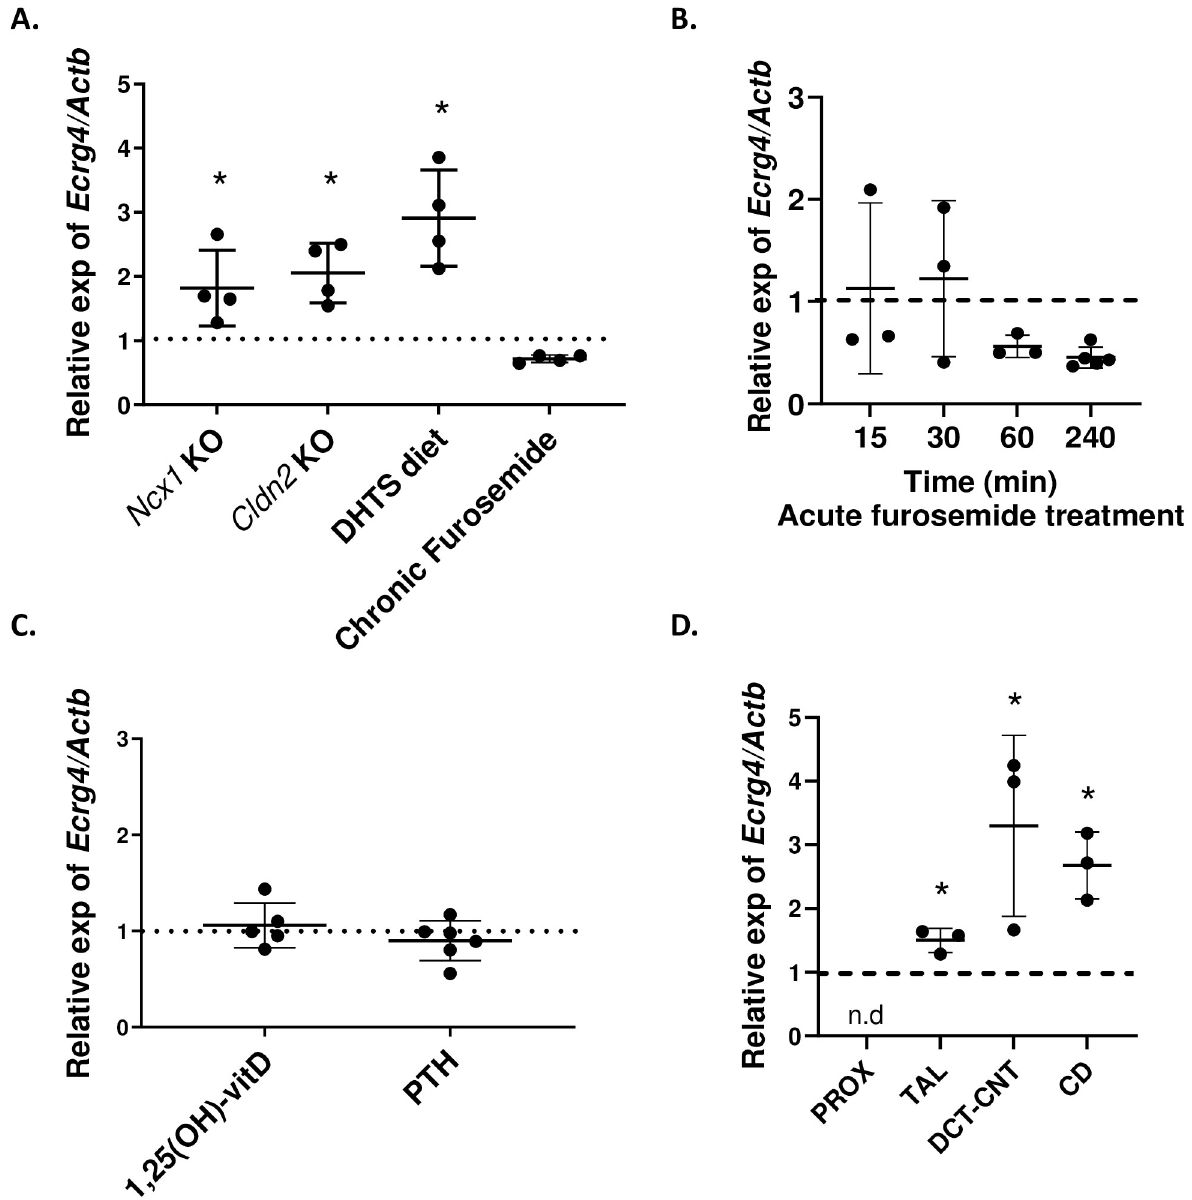
Fig 2. Ecrg4 transcript is upregulated in several hypercalciuric mouse models. (A) Ecrg4 mRNA expression (related to Actb and appropriate control mice for each condition, dotted line) was found increased in the kidneys of mice issued from several established hypercalciuric models (n = 4 males/condition), but not in mice exposed to chronic furosemide (injected with 20mg furosemide/kg body weight for 6 consecutive days). Ncx1 KO: Ncx1 KO mice. Cldn2 KO: Claudin-2 KO mice. DHTS: Dihydrotachysterol-treated mice (1,5mg/kg food) for 7 days. (B) Renal Ecrg4 expression after acute furosemide injection relative to renal expression of vehicle-injected male mice (dotted line). The mice were injected with 20mg furosemide/kg body weight and kidneys were harvested after 15, 30, 60 or 240min (n = 3–5 animals/group). (C) Renal Ecrg4 mRNA expression is not changed by the calcitropic hormones PTH or 1,25(OH) 2 -vitamin D. The kidneys were harvested 6h after calcitriol injection (n = 5), and 2h after PTH injection (n = 6). The dotted line at 1 represents renal Ecrg4 mRNA expression of vehicle-treated male mice. (D) Ecrg4 ’s regulation along the nephron of the hypercalciuric Ncx1 KO mouse model compared to control littermates (dotted line) (n = 3 males/condition). Data are shown as individual dots and mean ± SD. Stars indicate � p < 0.05, calculated using t test and Dunnett’s multiple correction.